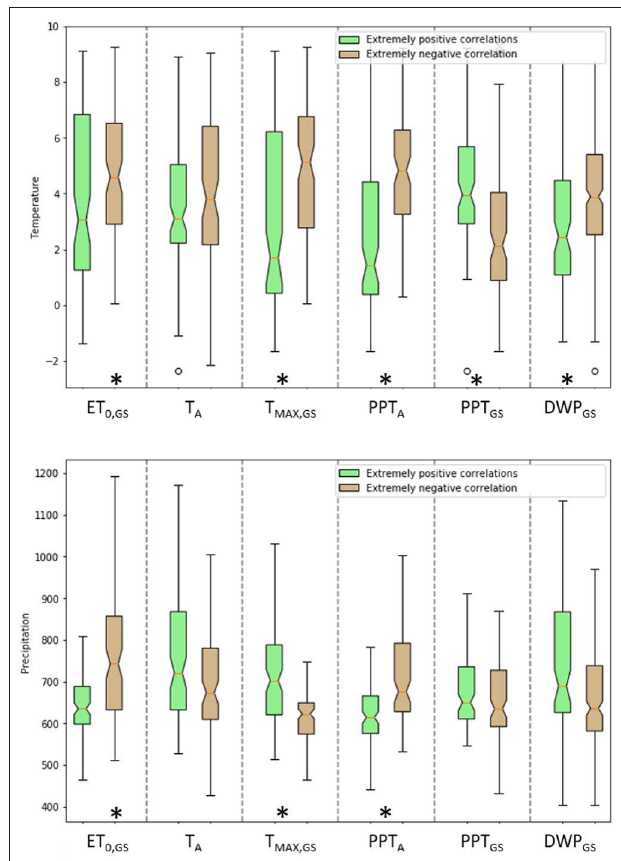
FIGURE 3 | Box plot of annual mean temperature (T A –top panel) and annual mean PPT (PPT A –bottom panel) of cells with correlations between each climatic variable and NDVI GS below 10th percentile (negative correlations, in brown) and above 90th percentile (positive correlations, in green). The orange line represents the median, the ends of the whiskers are computed as 1.5* IQR and the bottom and the top of the boxes correspond to the first and third quartile, respectively. The notches extend over the 95% confidence intervals of the median, as determined by bootstrapping. Stars at the bottom of each pair of bars denotes significant (at 5%) differences in the median values of mean T A (top) or mean PPT A (bottom) between pixels when the correlations with the corresponding climatic variable are extremely positive and extremely